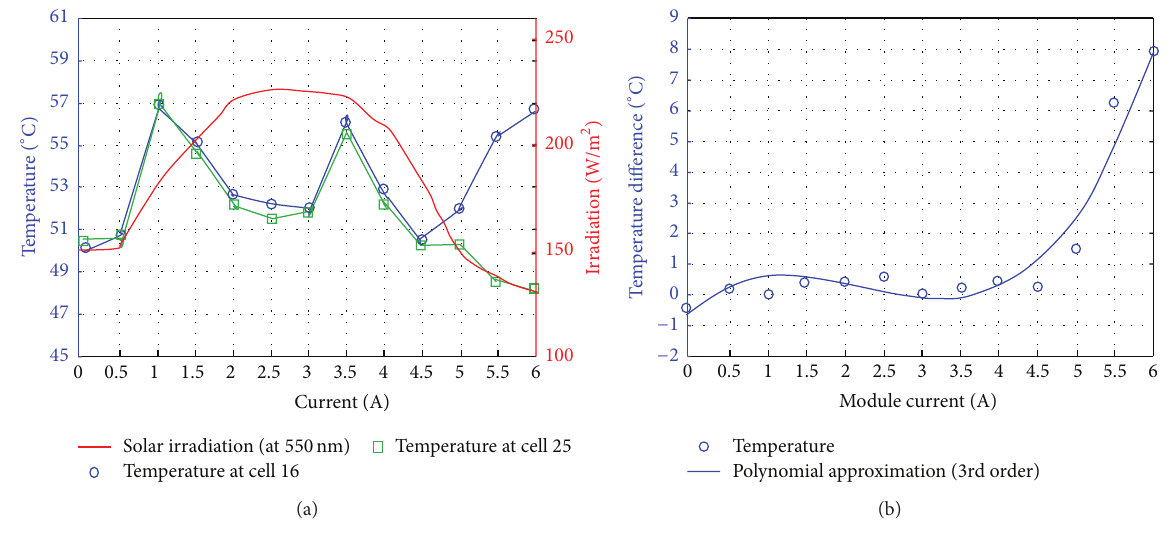
Figure 7: Current characterization under 0.5 A increments: (a) temperature graph and (b) temperature